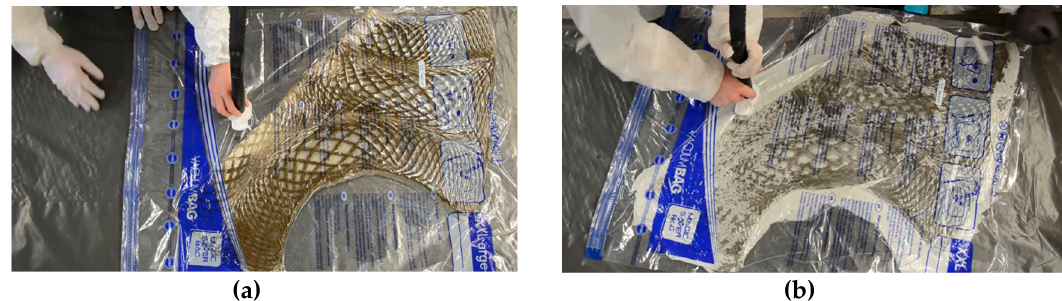
Figure 10. Resin vacuum infusion process ( a ), removal of excessive resin with a sacrificial material ( b ).